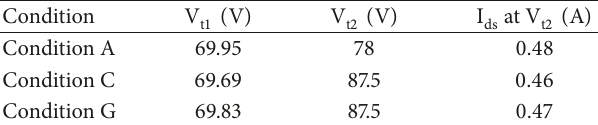
Table 2: Robustness results of different devices.